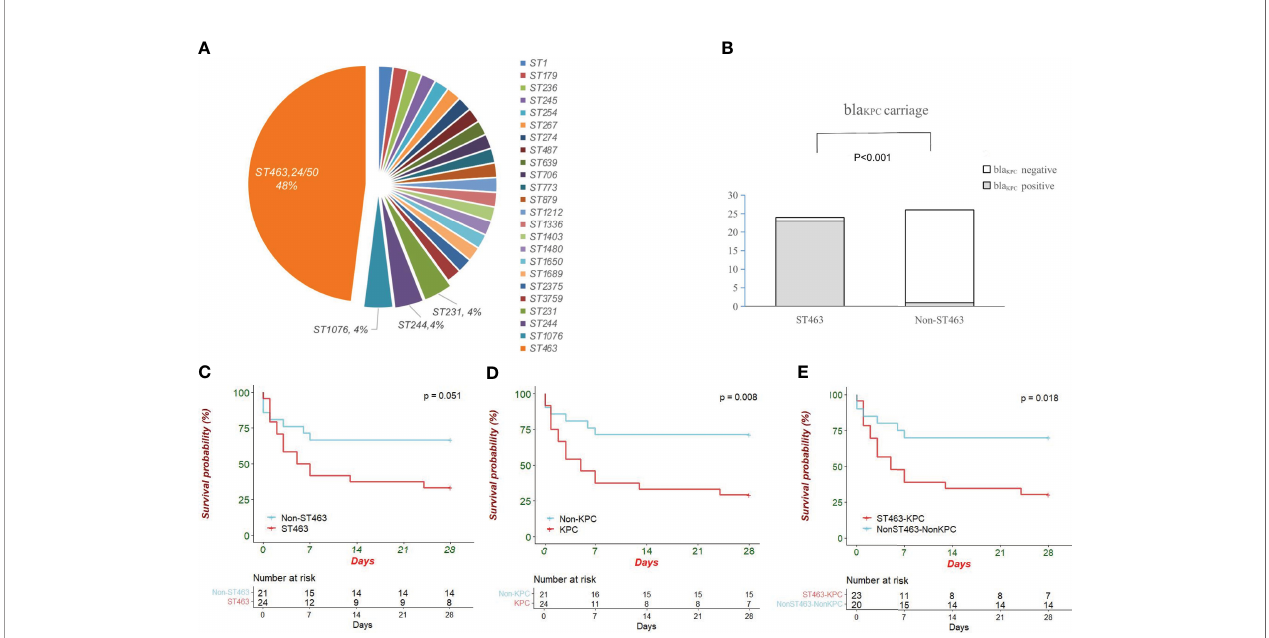
FIGURE 2 | (A) Pie chart showing sequence type distribution of 50 CRPA isolates; (B) Comparison of bla KPC carriage between ST463 and Non-ST463 strains (Fisher ’ s Exact Test). ST463 and bla KPC are highly associated (23 out of 24; 95.8%); (C) The Kaplan – Meier survival curves in patients infected with ST463 CRPA and with non-ST463 CRPA ( P = 0.05); (D) The Kaplan – Meier survival curves between the two groups of patients infected with KPC-producing CRPA and non-KPC- producing CRPA ( P = 0.008); (E) The K – M survival curves between KPC-producing ST463 CRPA and other STs CRPA that do not carry bla KPC (P = 0.018). The P value of Kaplan Meier ’ analysis was calculated with log-rank